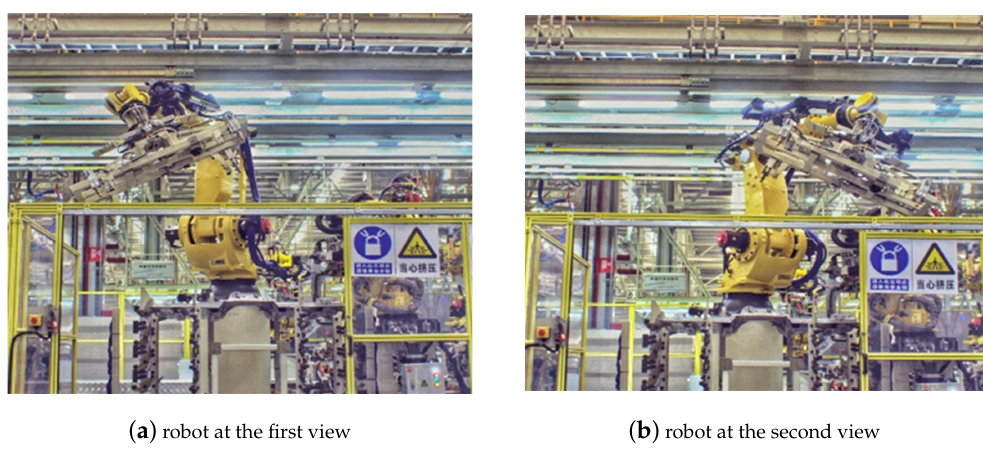
( a ) robot at the first view ( b ) robot at the second view Figure 10. Experimental setup for robot intelligent grasping system: ( a ) Robot at the first view; ( b ) Robot at the second